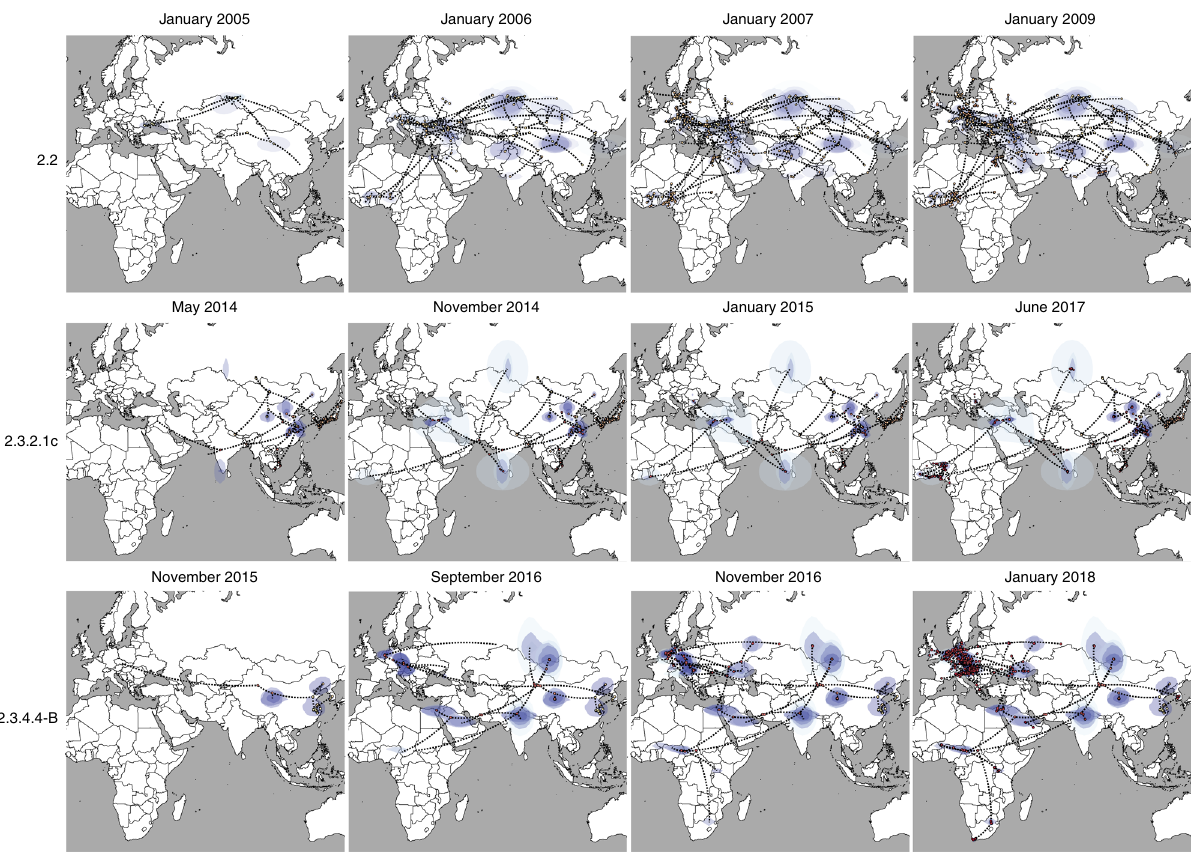
Fig. 2 Global spatiotemporal dispersal of the three HPAI H5Nx clades. Dispersal patterns inferred using continuous phylogeographic analysis of the epi-based datasets are shown for four time slices for each of the three HPAI H5Nx clades. The black dashed lines and the dots represent part of the branches and the nodes of the MCC tree up to each of the indicated time. Dots are coloured according to the time (from yellow for the oldest to red for the youngest). Contours represent statistical uncertainty of the estimated locations at the internal nodes (95% credible contours based on kernel density